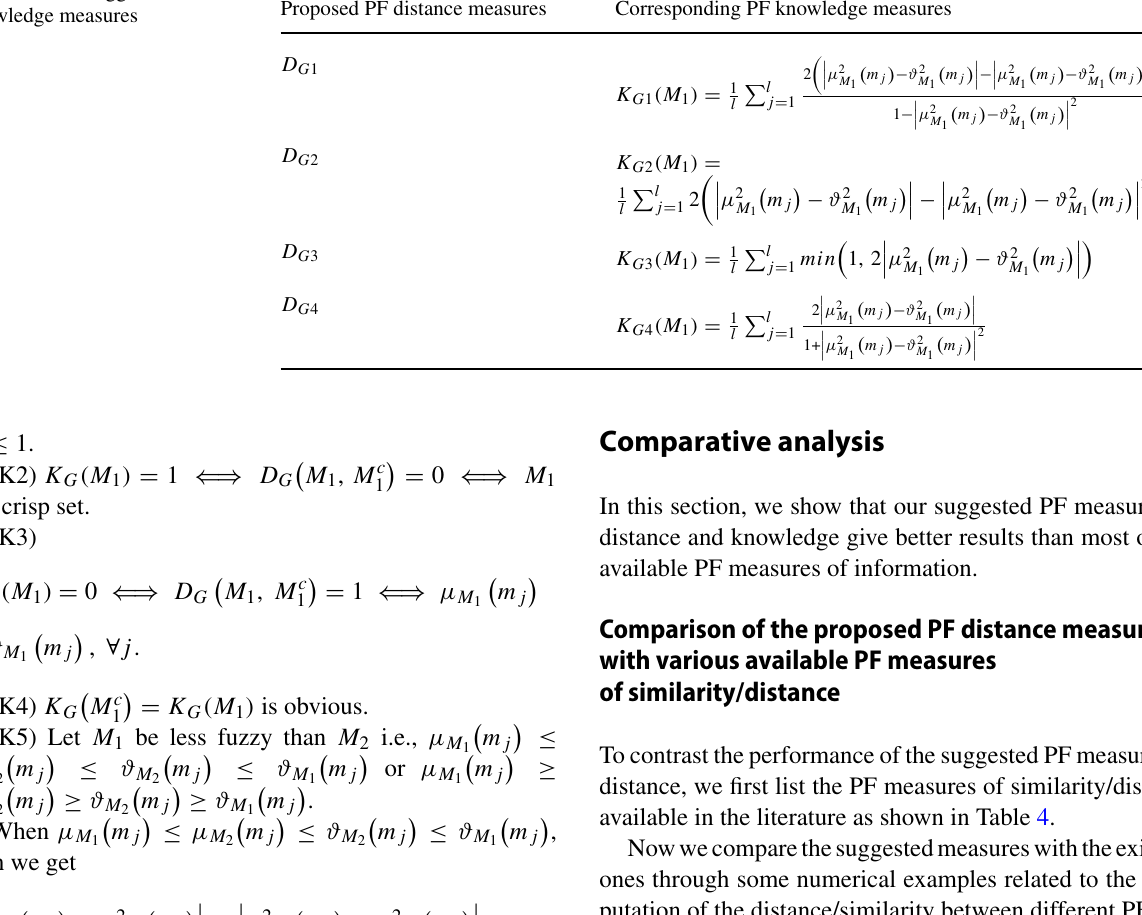
Table 3 Some suggested PF knowledge measures Proposed PF distance measures Corresponding PF knowledge